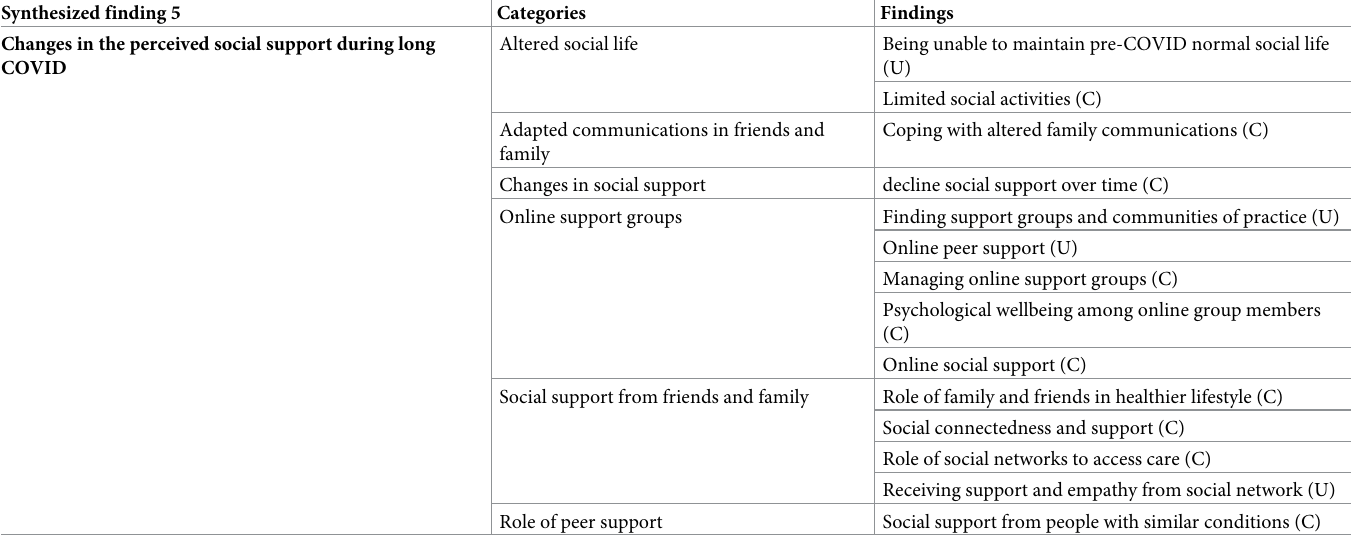
Table 7. Findings and categories within synthesized finding